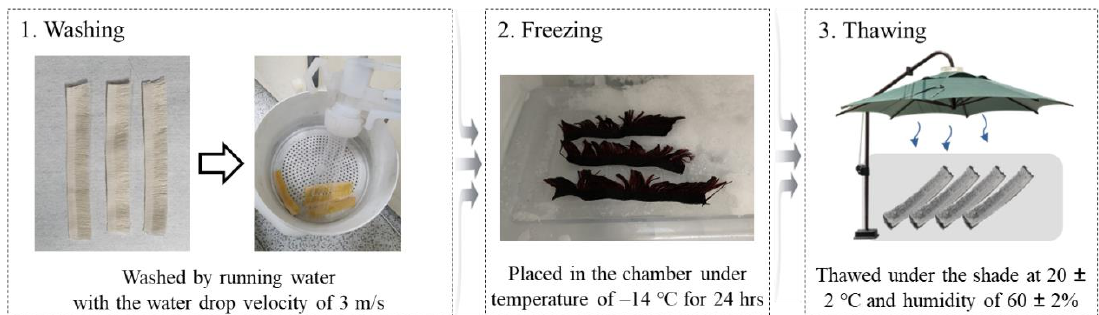
Figure 3. Washing and freeze–thaw process of the textile fabrics with porous materials.